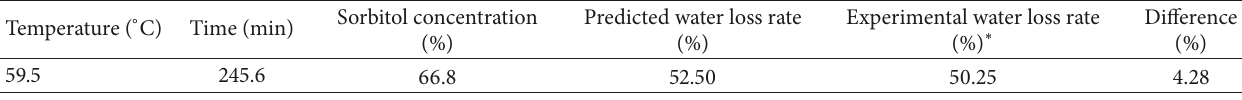
Table 4: Optimal conditions and validation for strawberry osmotic dehydration.